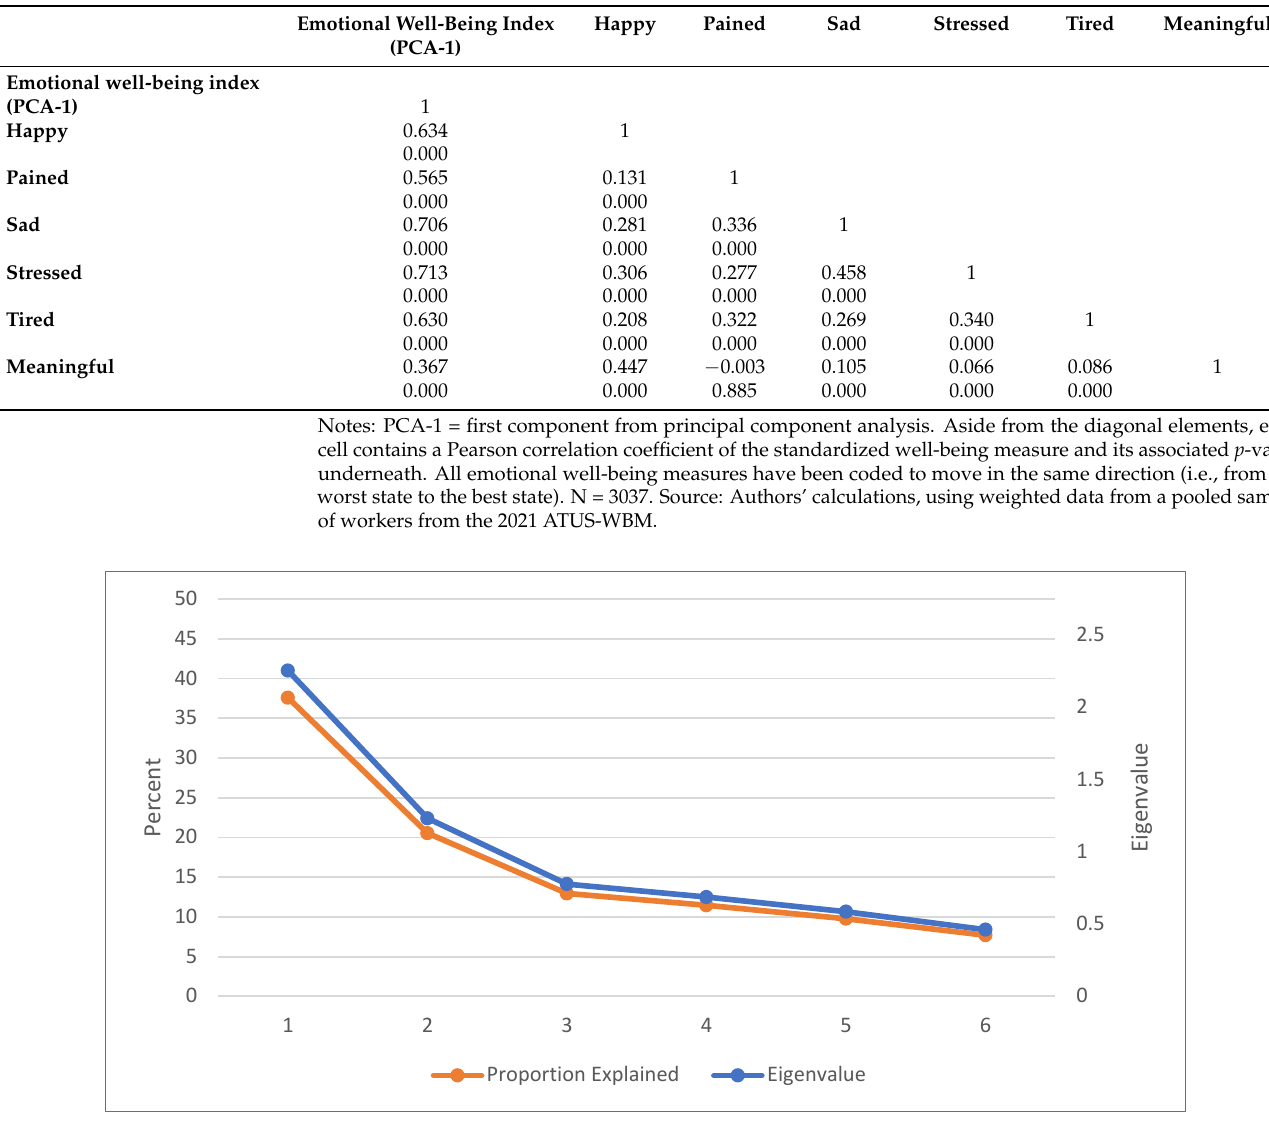
Table A3. Matrix of Pearson correlation coefficients involving six well-being measures.